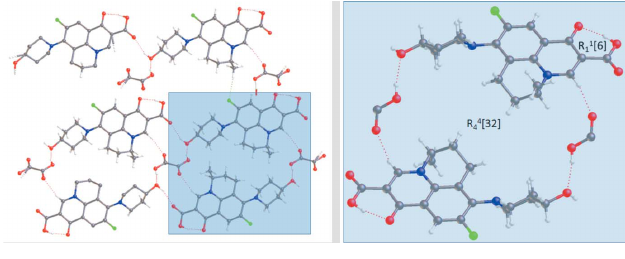
Figure 2 Packing of the title compound with hydrogen bonds depicted by dashed lines.